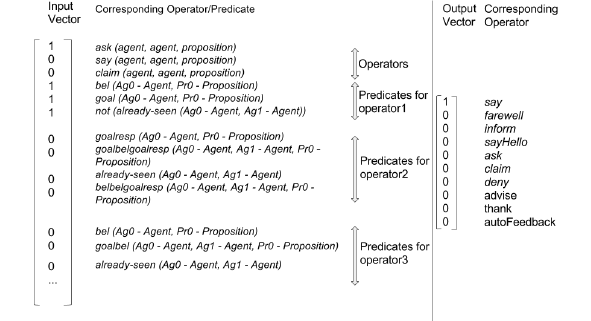
Figure 5: Vector representations for the operator “ask” and suc- cessive operator “say” for the features respective to the relevant predicates in the encoding scheme sans speech model.